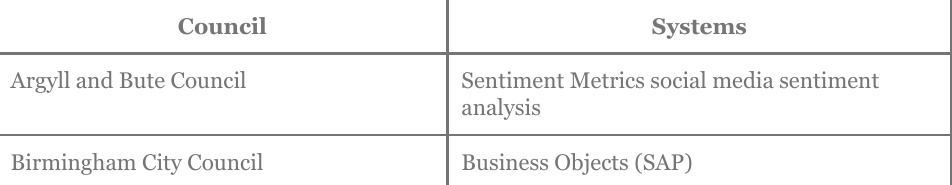
Table 2: Predictive analytics systems in UK public